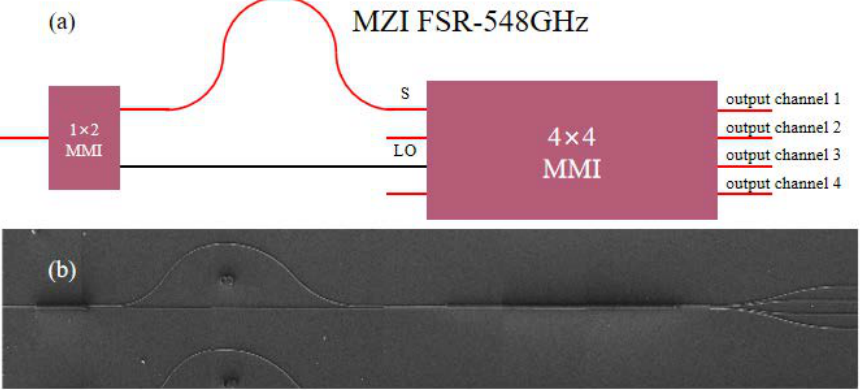
Figure 10. ( a ) Structure and ( b ) scanning electron microscope image of fabricated hybrid with a Mach Zehnder interferometer (MZI) delay line.